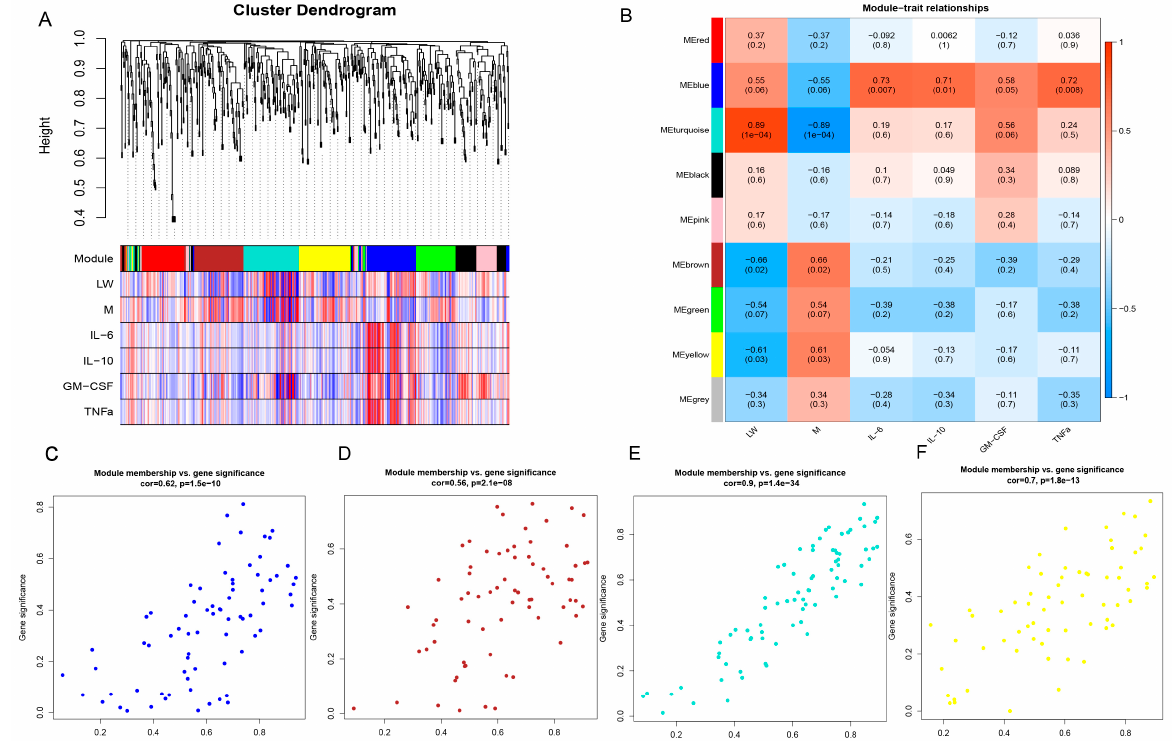
Figure 4. Weighted gene correlation network analysis (WGCNA) of all metabolites identified from different pig breeds. ( A ) Module clustering tree; ( B ) Phenotypic and modular correlation diagrams; ( C – F ) A scatterplot of gene significance (GS) vs. module membership (MM) in the four modules that showed the closest relationship with phenotypes.